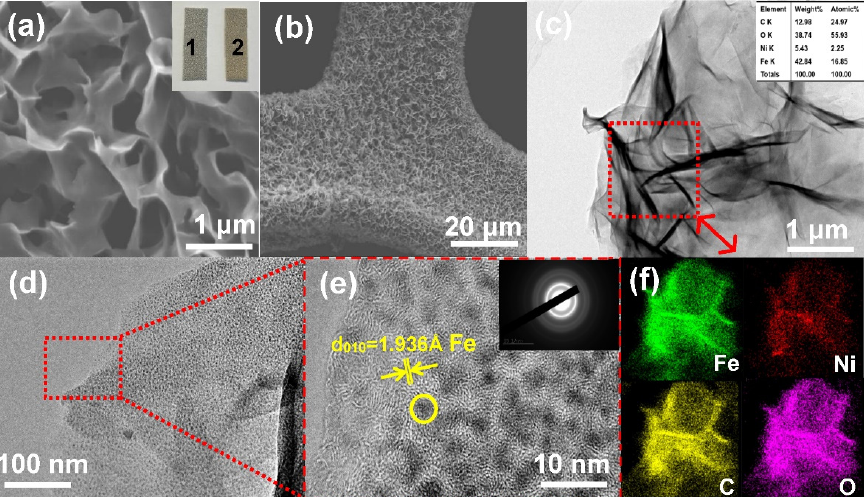
Figure 2. ( a , b ) SEM images of Fe(BPDC)–3. (Inset: optical image of 1 blank Ni foam, 2 Fe(BPDC)–3).